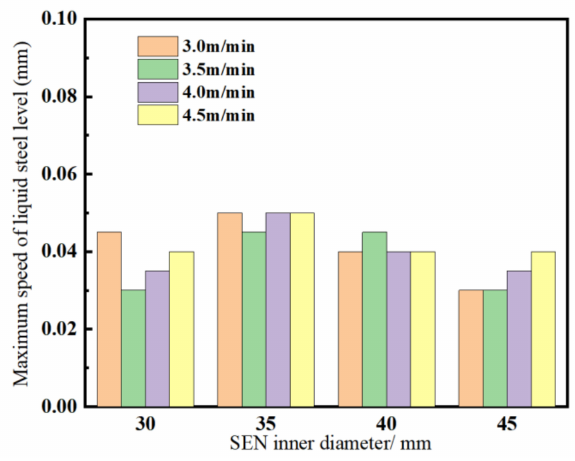
Figure 7. The maximum flow speed of mold surface fluid under varying SEN inner diameters.